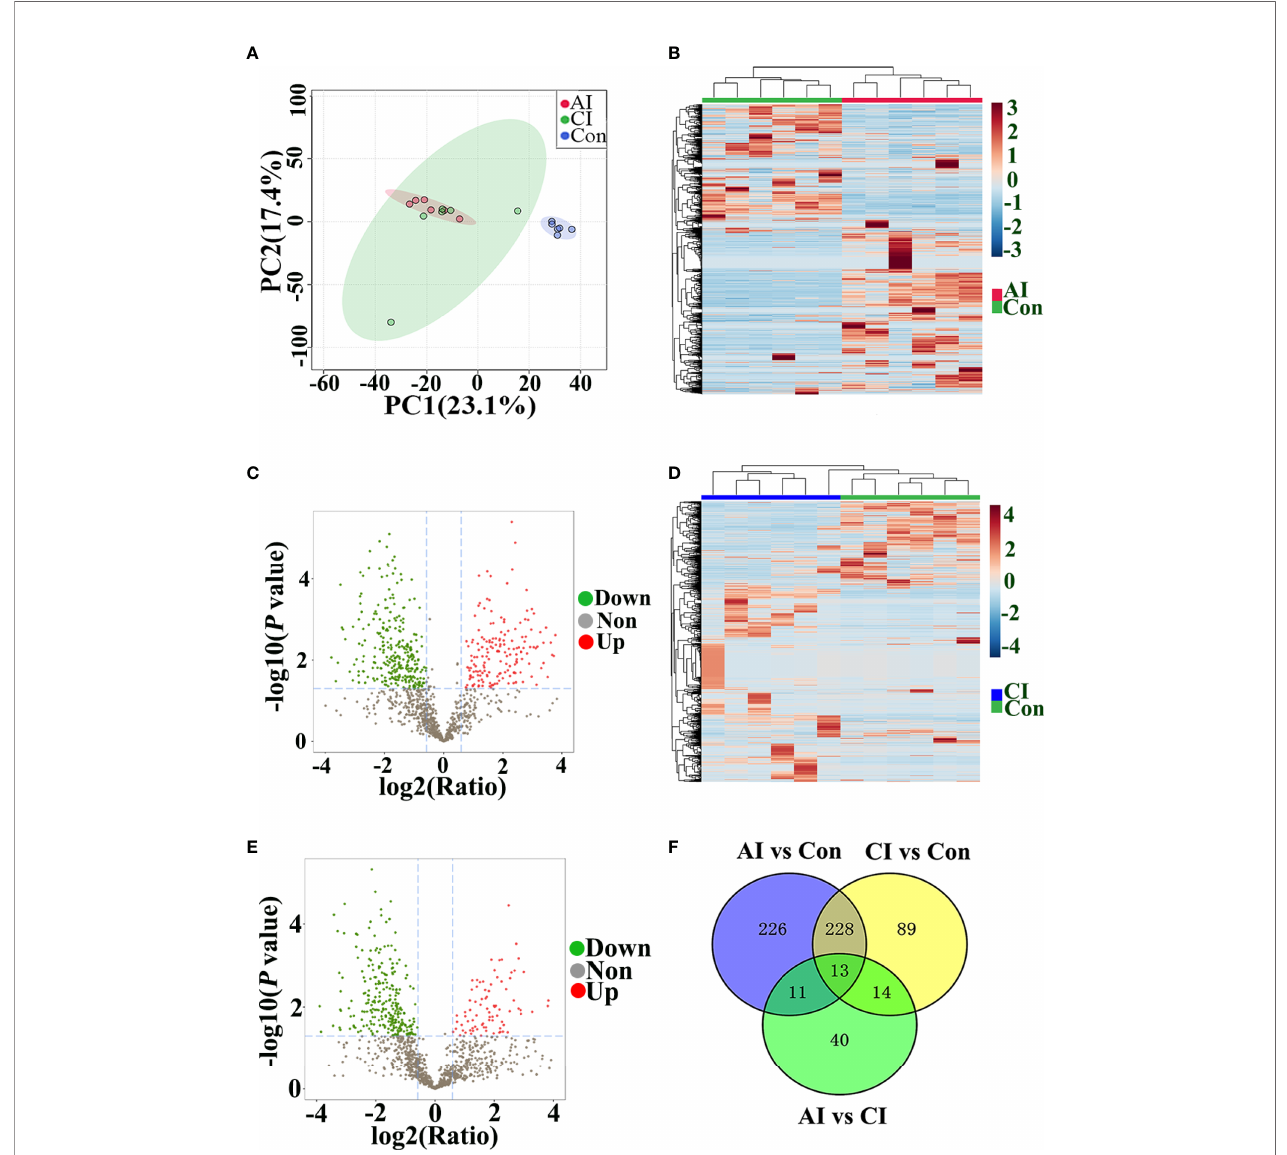
FIGURE 5 | Peptide pro fi le analysis among different groups. (A) PCA scores plot comparing the control group, acutely infected group and chronically infected group. (B) Heat map of peptides identi fi ed in both acutely infected group and control group. Columns were hierarchically clustered based on a complete linkage using Pearson correlation coef fi cients as the distance measure. (C) The volcano plot shows the individual statistically signi fi cant peptide between acutely infected group and control group. In this plot, the x-axis is log2 fold-change, which shows the direction of the change (negative scale is decrease and positive scale is increase) in the levels of peptide intensity, while the y-axis is the -log10 p -value, which shows the signi fi cance of the change. (D) Heatmap of peptides identi fi ed in both chronically infected group and control group. (E) The volcano plot shows the individual statistically signi fi cant peptide between chronically infected group and control group. (F) Venn diagram shows number of DEPs among different comparison